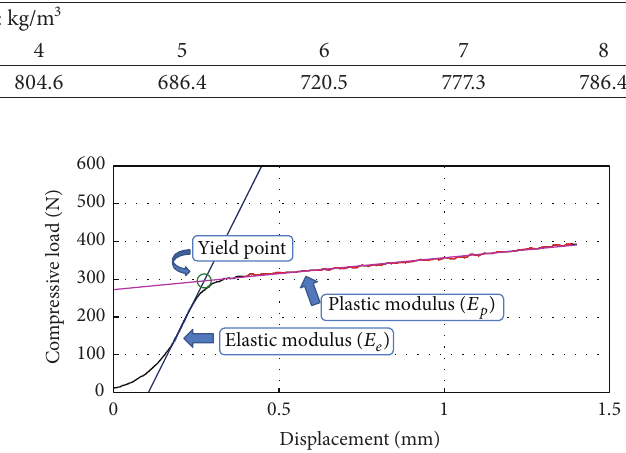
Table 3: Mass densities of NGH specimens.